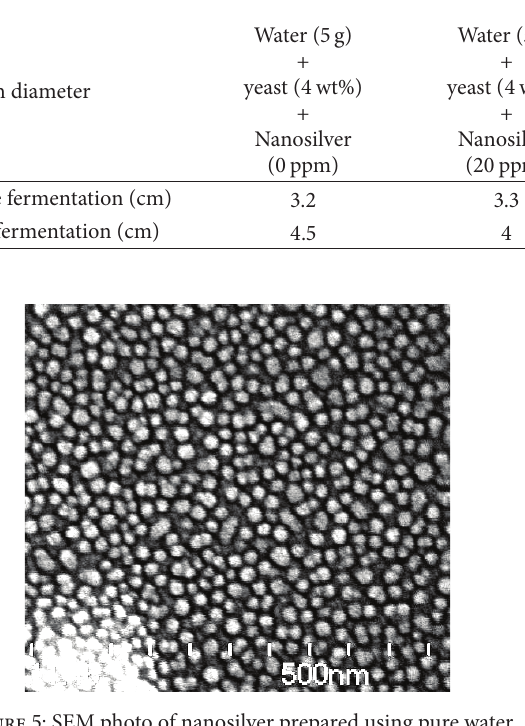
Figure 5: SEM photo of nanosilver prepared using pure water.